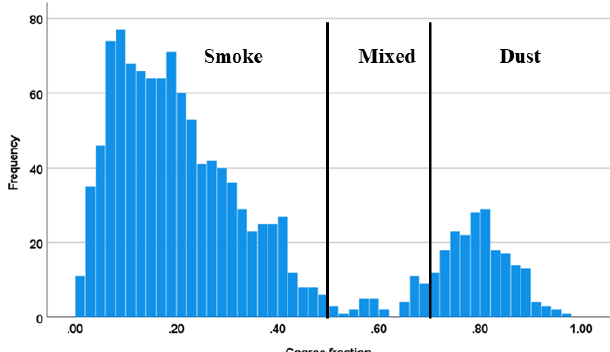
Figure 4. Histogram of coarse aerosol fraction (CAF) at Keeler, CA, using regulatory PM 2 . 5 and PM 10 data for hours with PM 2 . 5 of > 25µgm − 3 . We assume that the aerosol is primarily smoke when the CAF is < 0.5, mixed when the CAF is between 0.5 and 0.7, and dust for times when the CAF is >